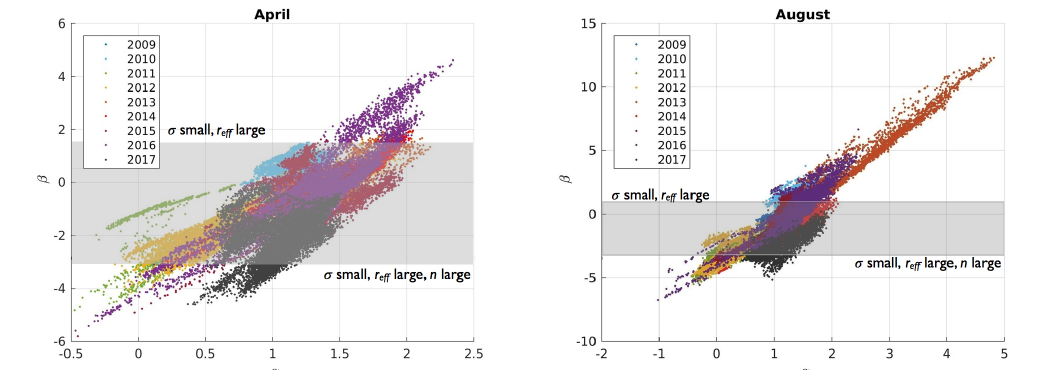
Figure 10. Correlation between the modified Ångström exponent α and its spectral slope β for the haze season (April) and for summer conditions (August) of the years 2009–2017. The grey area indicates the possible combinations for α and β using the Mie calculus of Figure